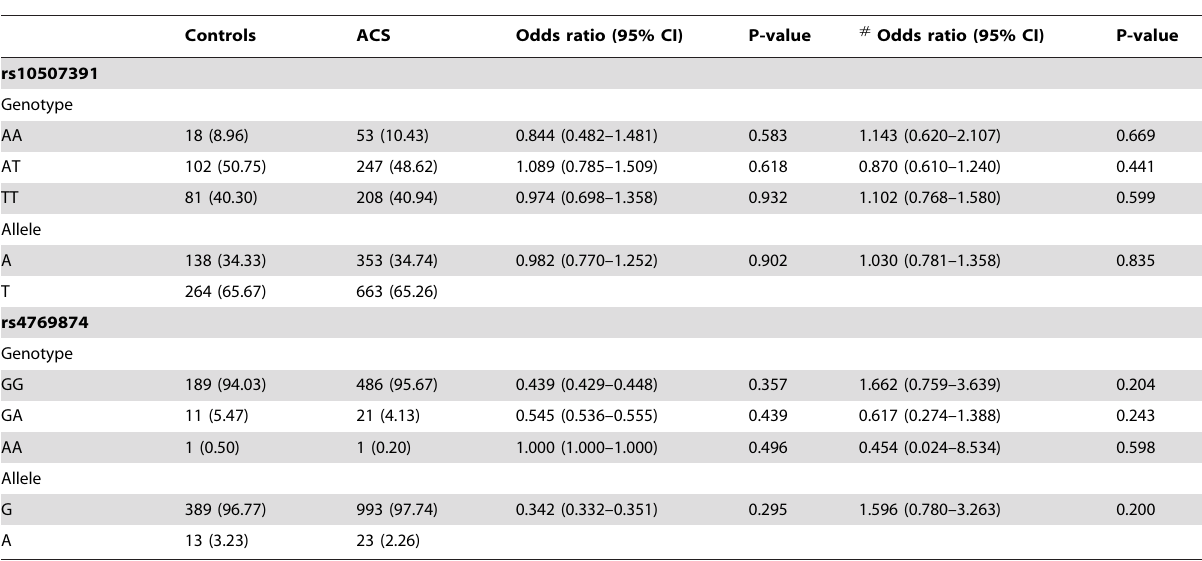
Table 3. Distribution of ALOX5AP polymorphisms in ACS and control groups.